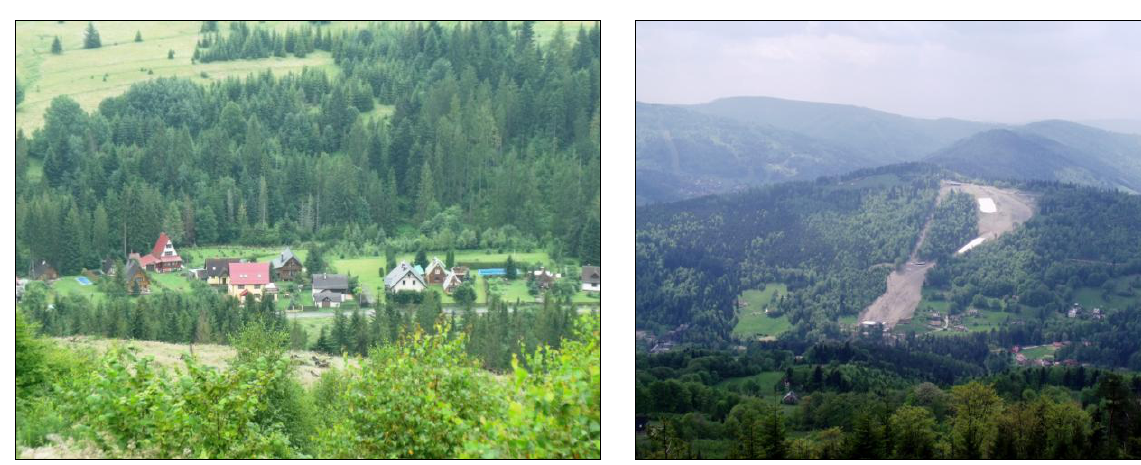
Fig. 6. Second home estates – Bory in the Raczańskie mountain range 2014